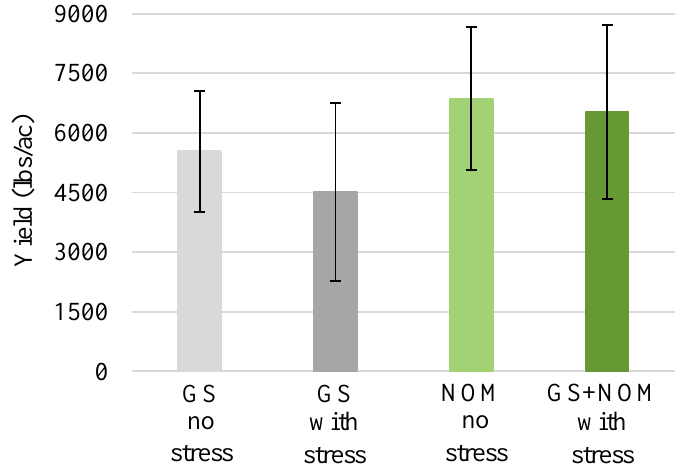
Figure 6. Average avocado yields from the drought and salt stress field trial for the grower standard (GS) non-stressed plants, GS stressed plants, NOM-based biostimulant treated non-stressed plants, and GS + NOM-based biostimulant treated stressed plants. Error bars represent one standard deviation. See also Supplementary Table S5.